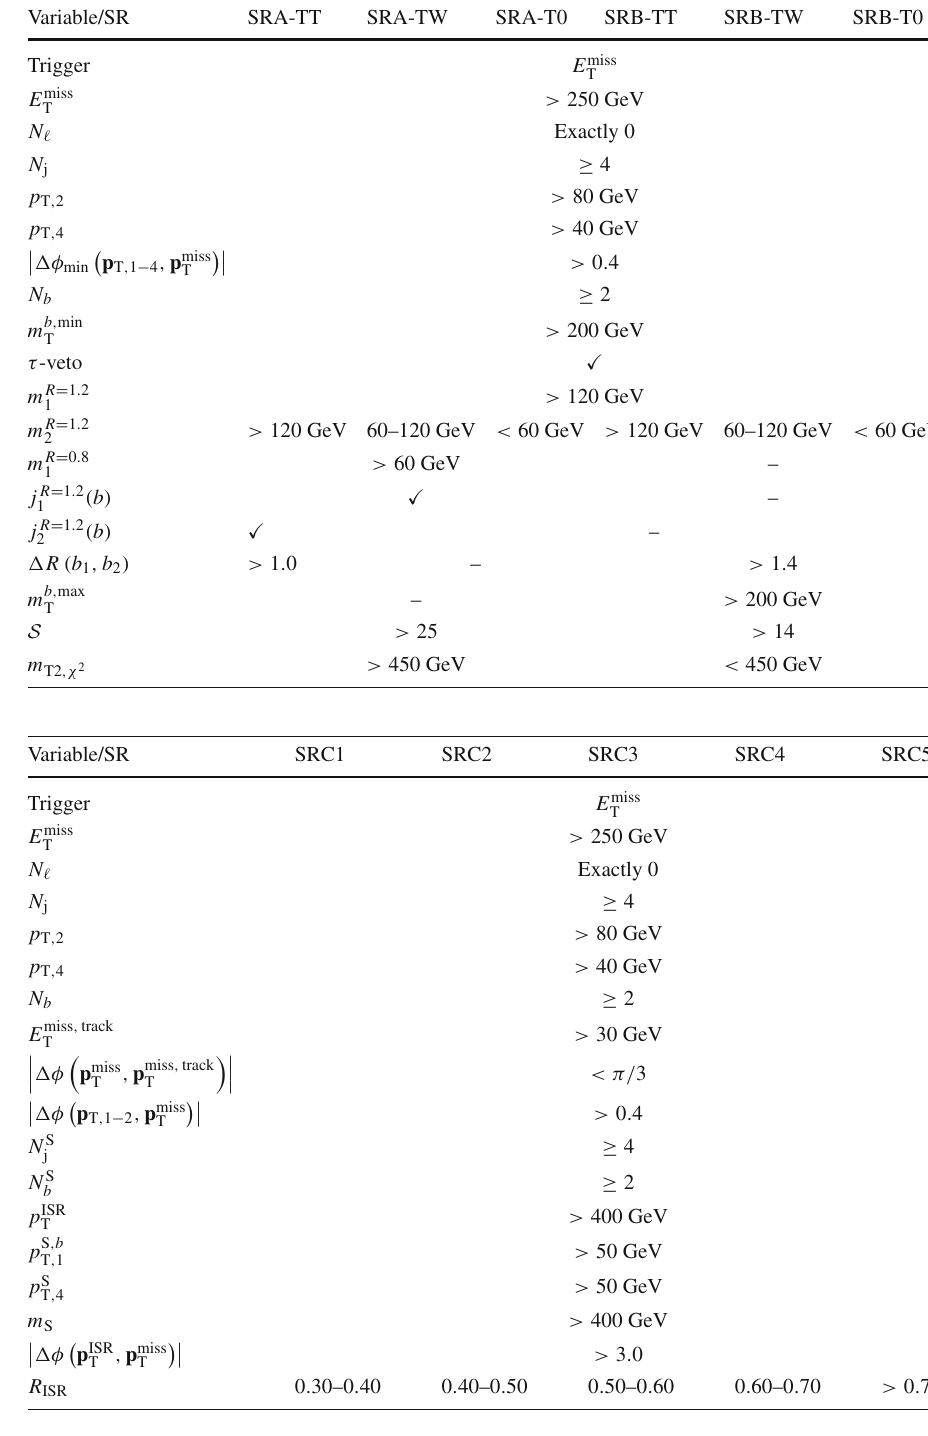
Table 2 Selection criteria for SRA and SRB. Each signal region is separated into three categories based on reconstructed top candidate masses. A dash indicates that no selection is applied